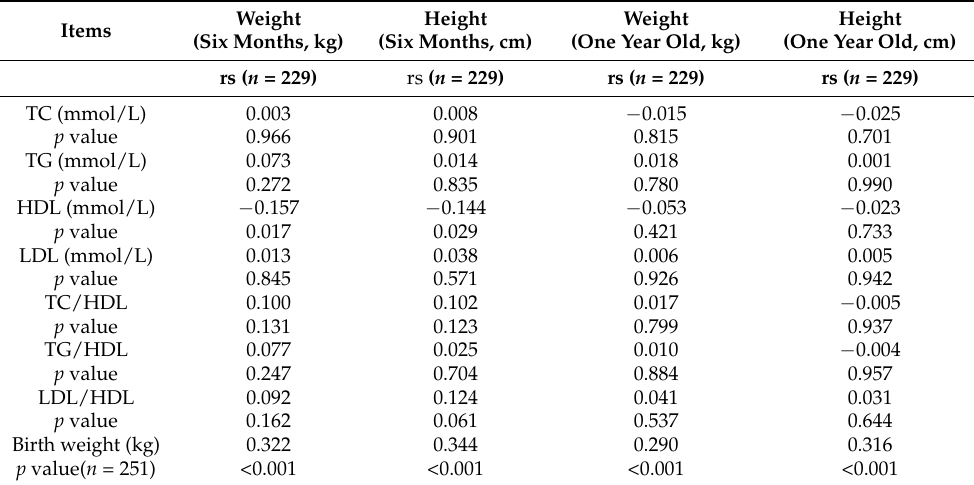
Table 4. Correlation between blood lipid levels of pregnant women, birth weight and the height and weight of infants.